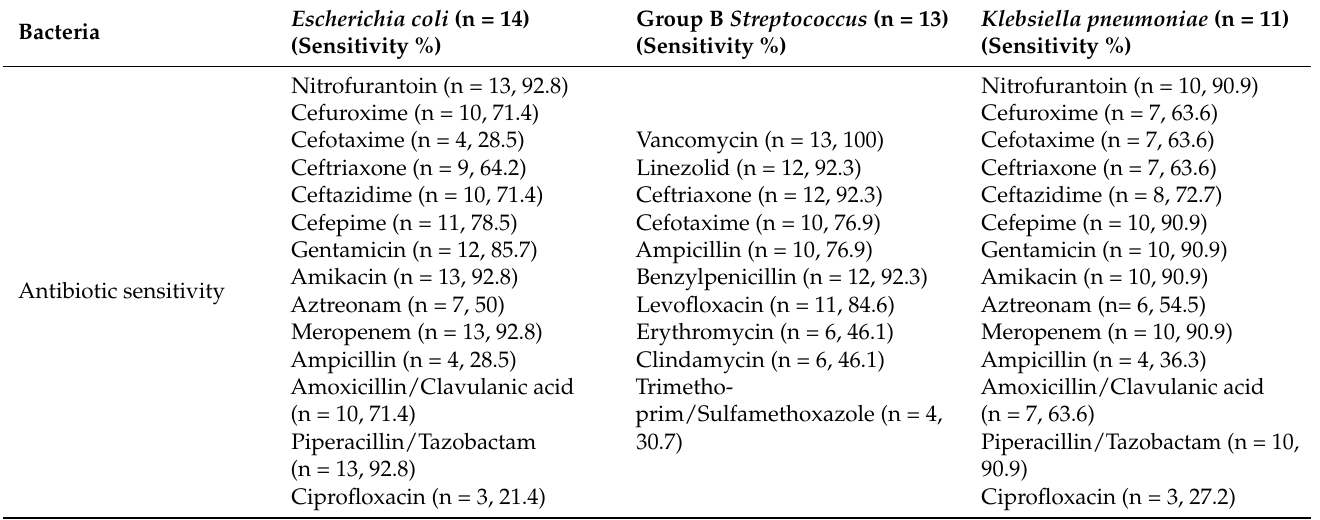
Table 4. Culture isolates and antibiotic